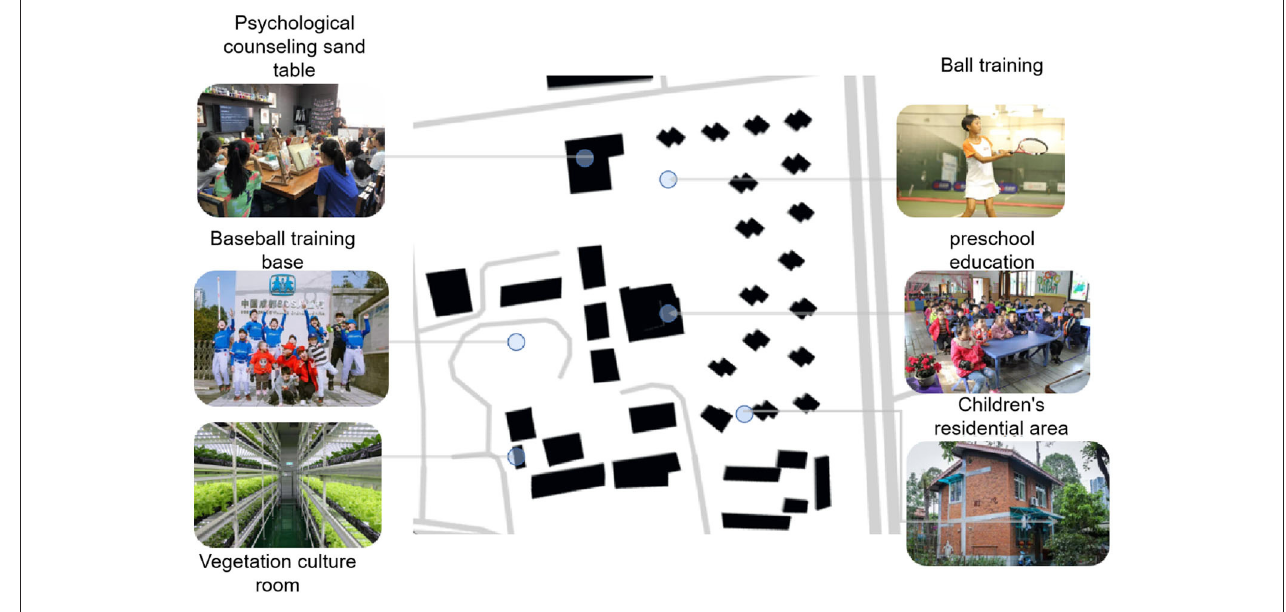
FIGURE 4 | Summary of the plane model of children’s village.